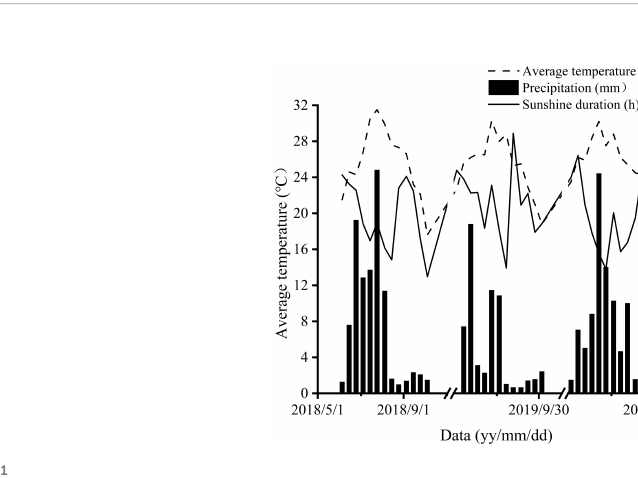
FIGURE 1 The meteorological factors for 2018 – 2020.